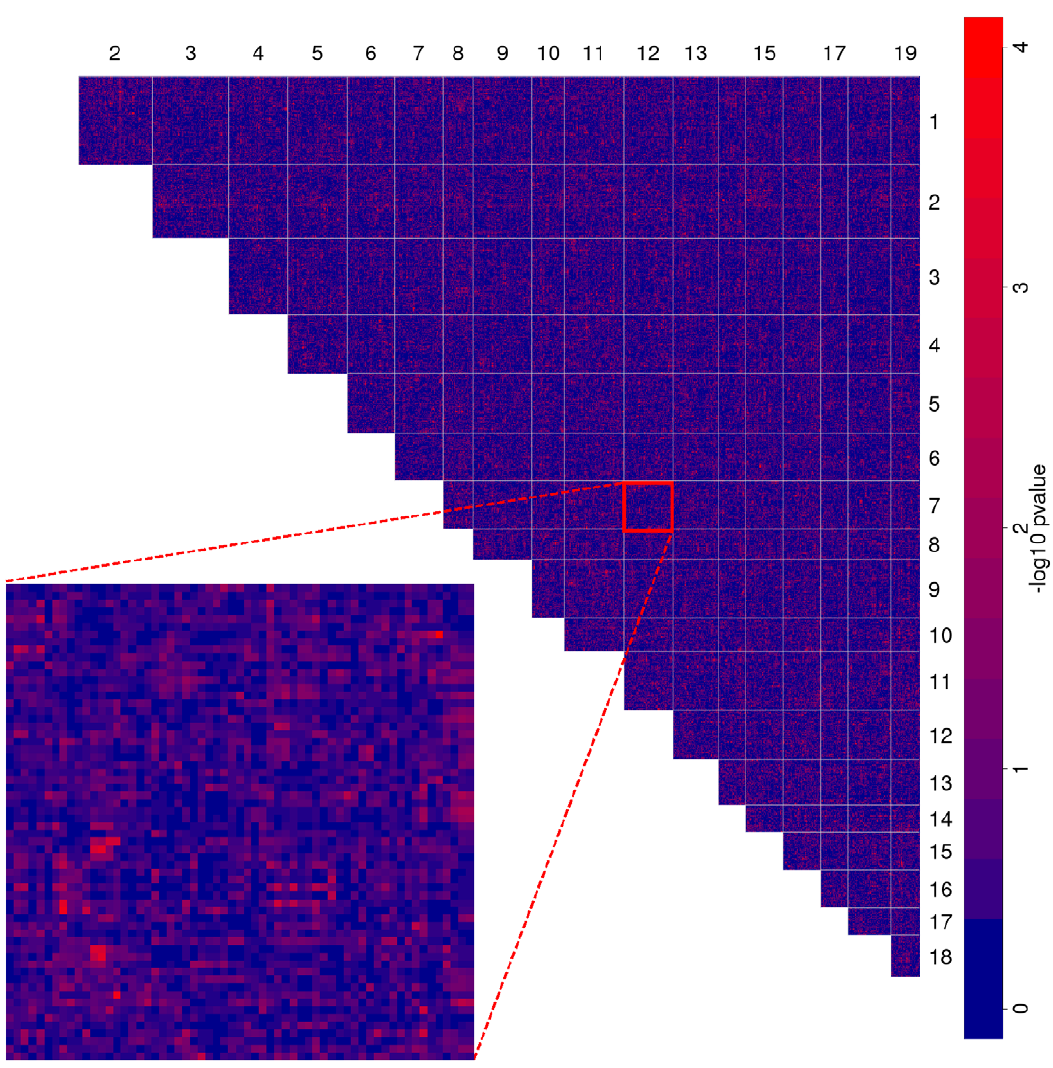
Figure 2. Genome-wide map of allele incompatibilities. The heatmap shows the negative log 10 p-values of each LD block combination on different chromosomes. Light red spots show putatively interacting loci. Inset shows an enlargement of chromosome 7 versus chromosome 12 .